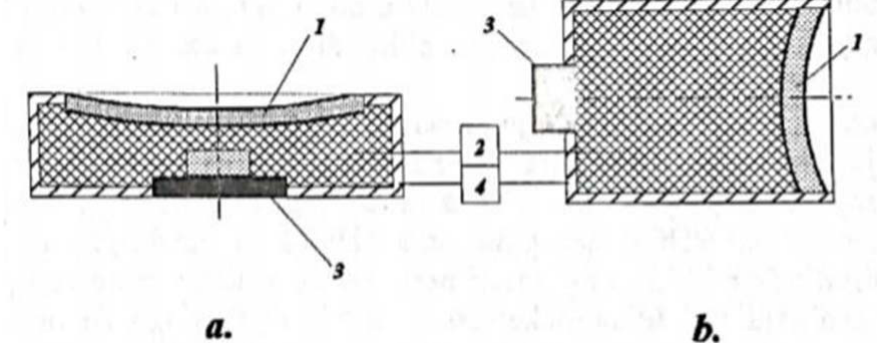
Figure 3. Schematic representation of the solution based on the Misznay Schardin effect (a anti-tank mine; b-EFP; where: 1-liner, 2-exp. charge, 3- activation mechanism, 4-metal casing)